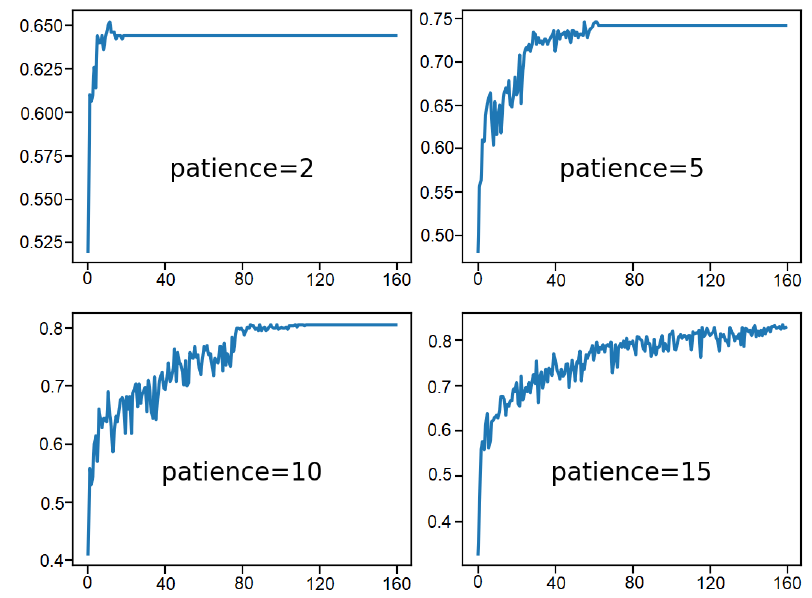
Figure 14. Result analysis of various patience values: training loss over